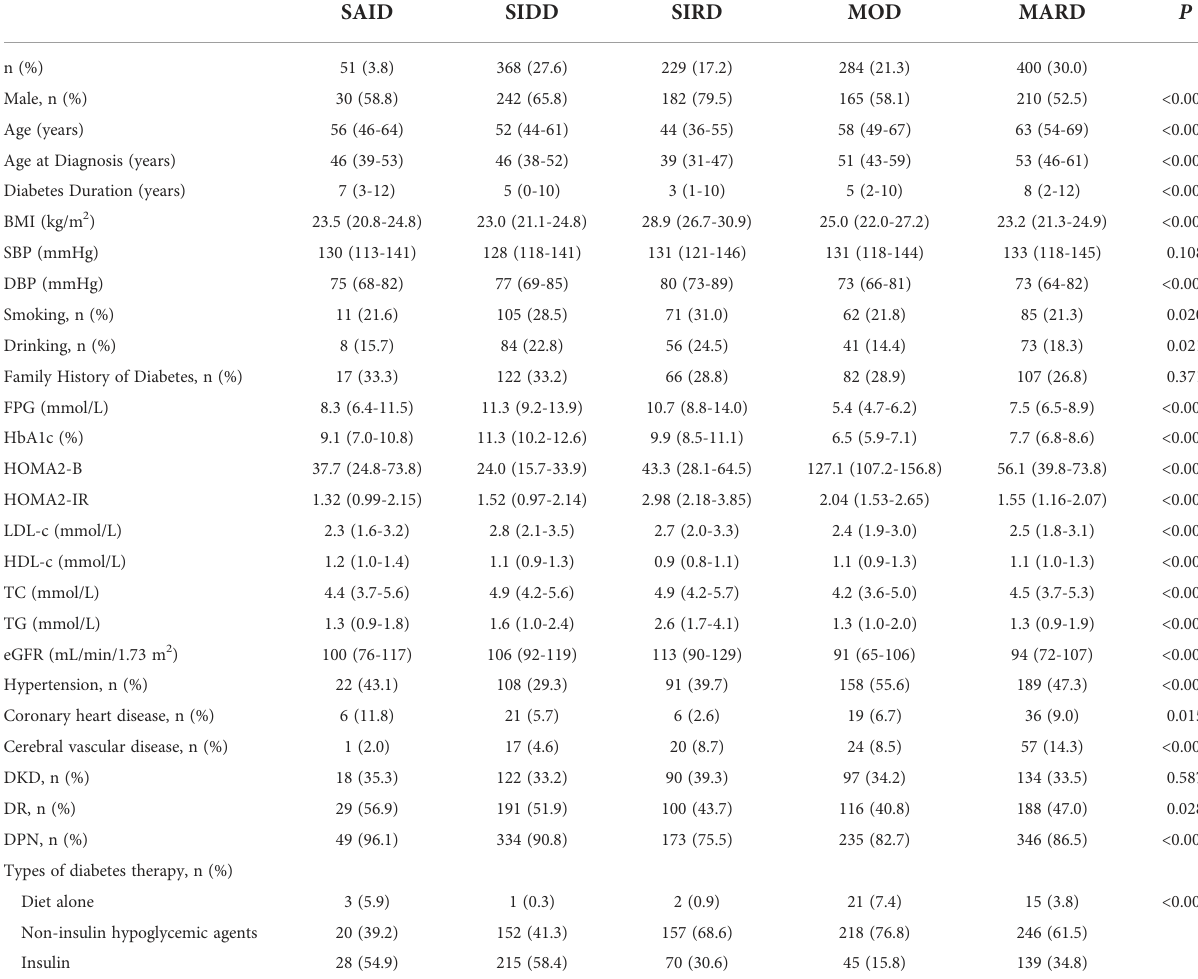
TABLE 1 Baseline characteristics of clustering-based subgroups.